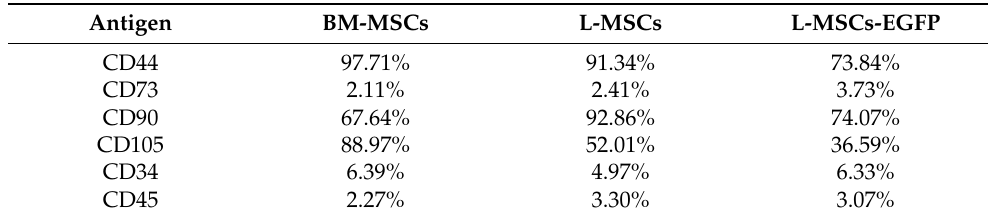
Table 4. Surface antigen profile of LSCs and LSCs-EGFP. The ratio of the number of cells expressing the antigen to the total number of cultured cells,